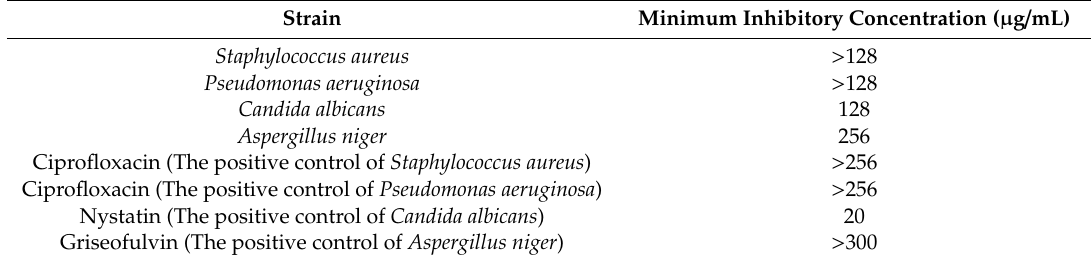
Table 1. Antimicrobial activity of compound 2 against several microbial strains.